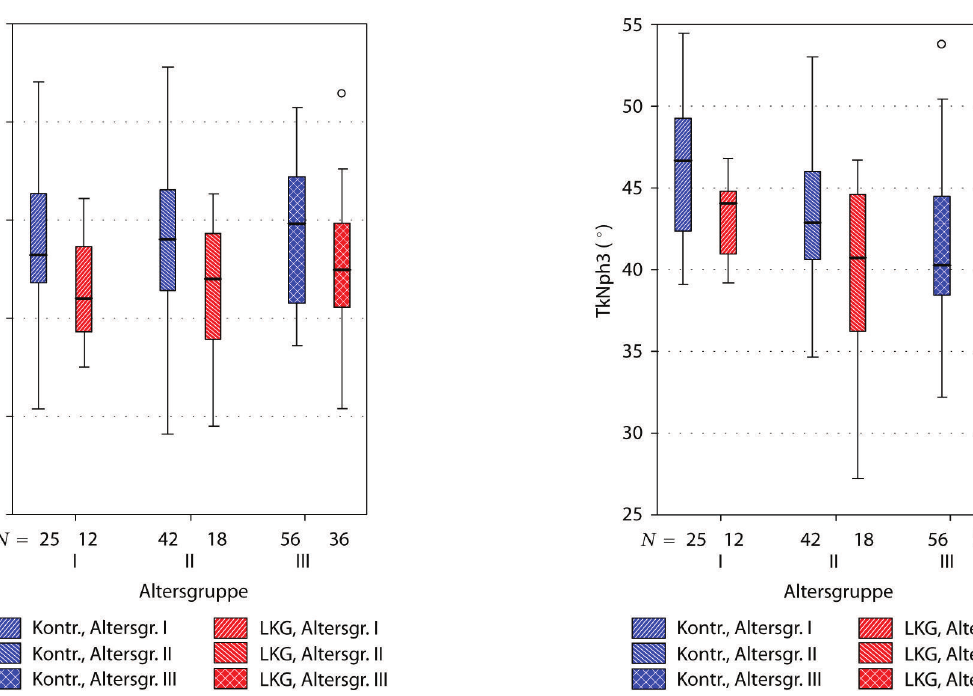
Figure 8: Boxplot illustrating significant di ff erences between uCLP group and controls concerning bony nasopharyngeal depth (angle AA-S-Spp). “Altersgruppe”: age subgroups, explanation see Table 1. “LKG”: uCLP group (cleft). “Kontr.”: control group